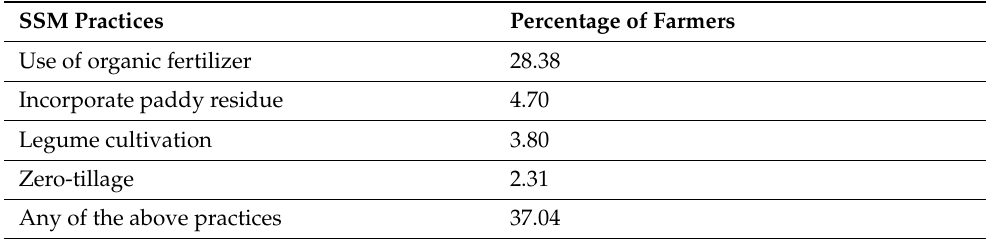
Table 2. Adoption of sustainable soil management practices by paddy farmers. SSM